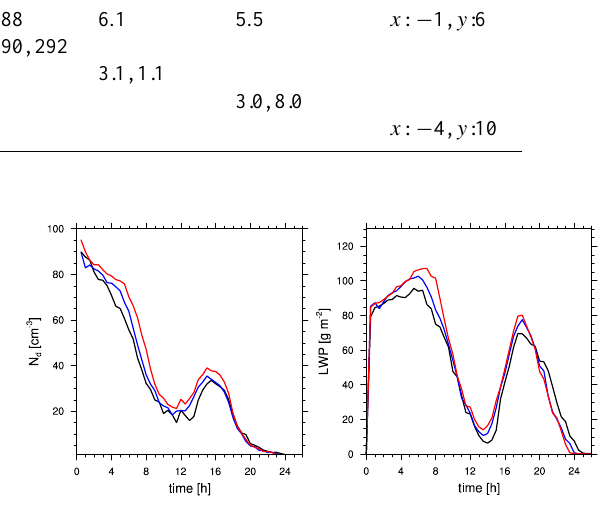
35 Fig. 3. Time evolution of N d and LWP under different vertical spacing: 20 m (black), 10 m (blue), and 5 m Fig. 3. Time evolution of N d and LWP under different vertical spac- (red)forcleancondition. ing: 20m (black), 10m (blue), and 5m (red) for clean